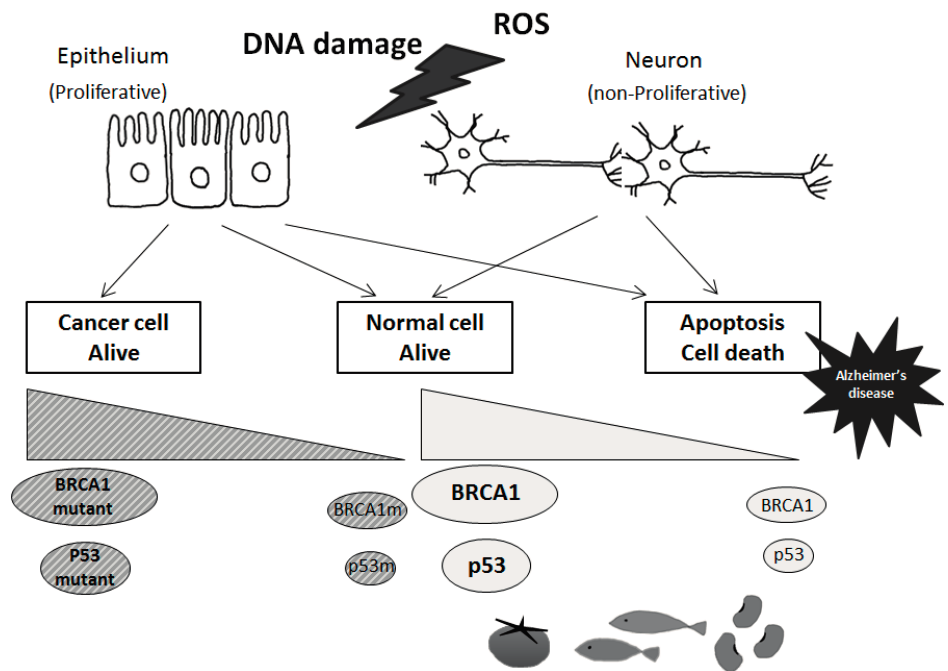
Figure 3. Tumor suppressor-dependent cellular fates in cancer and Alzheimer’s